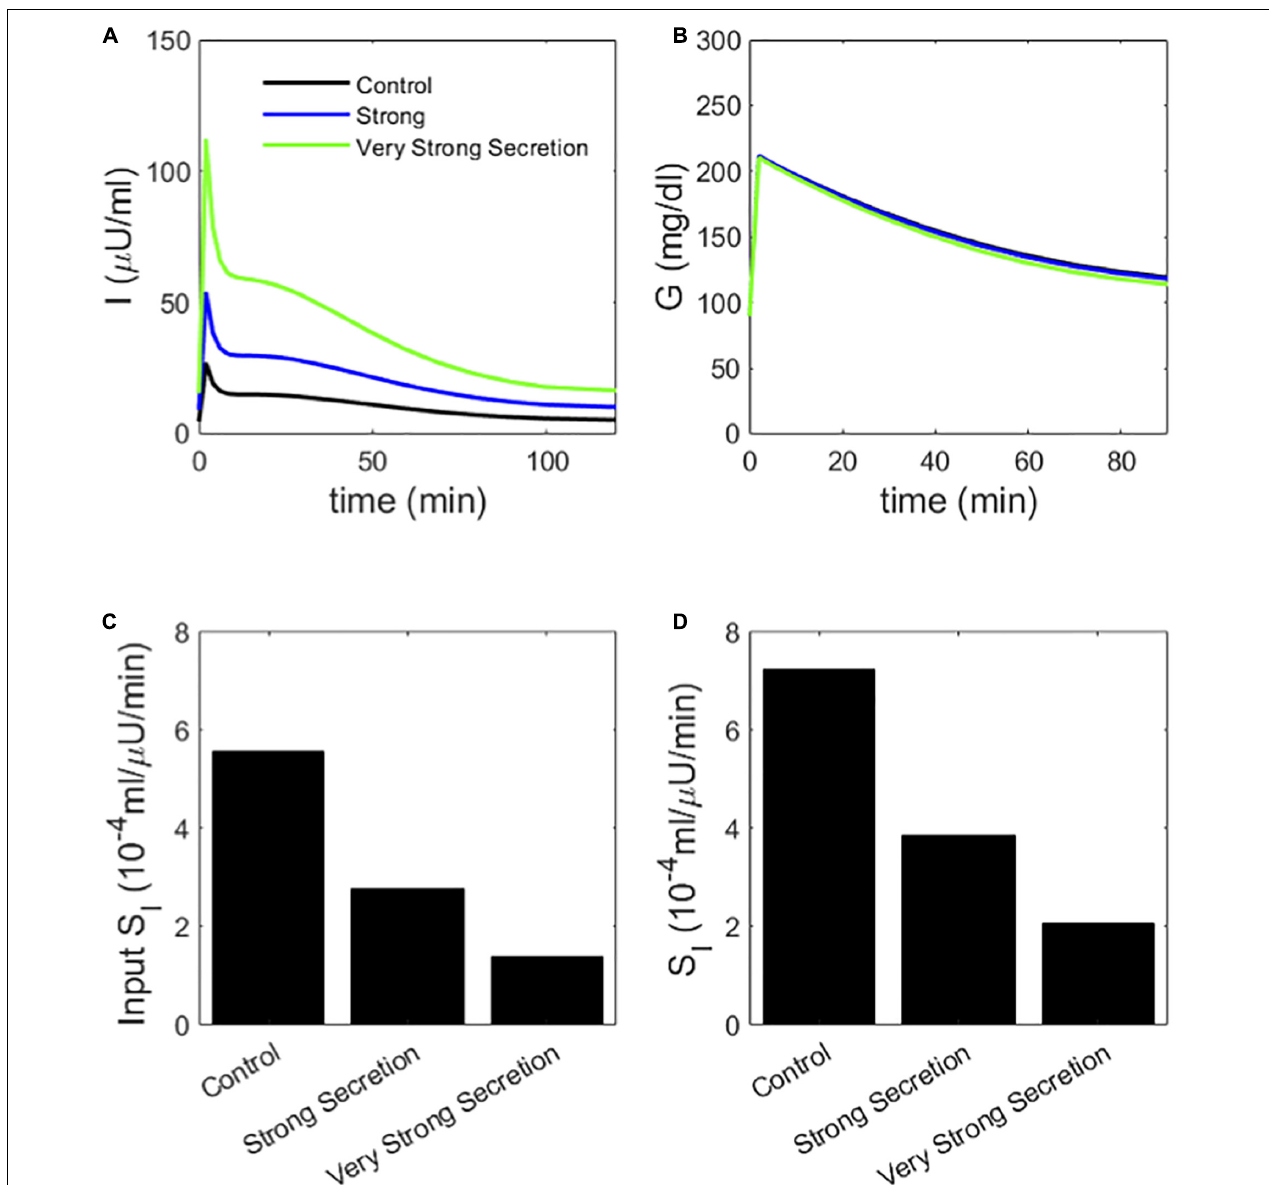
FIGURE 6 | (A) insulin and (B) glucose during a simulated IVGTT. The blue and green traces represent cases of AIR increased by increasing the rate σ of vesicle docking in the synthetic model. MINMOD reports a reduced S I (C) in agreement with the assumed values (D). Cases correspond to Control 1, 2, and 4 in Figure 3